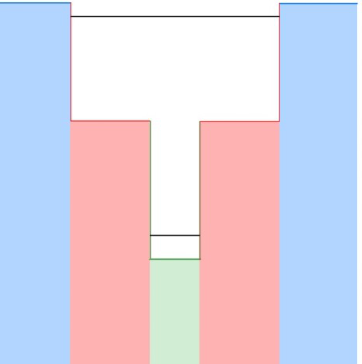
Figure 9. A band diagram of a DWELL structure, with a barrier layer (blue), well layer (red), and dot layer